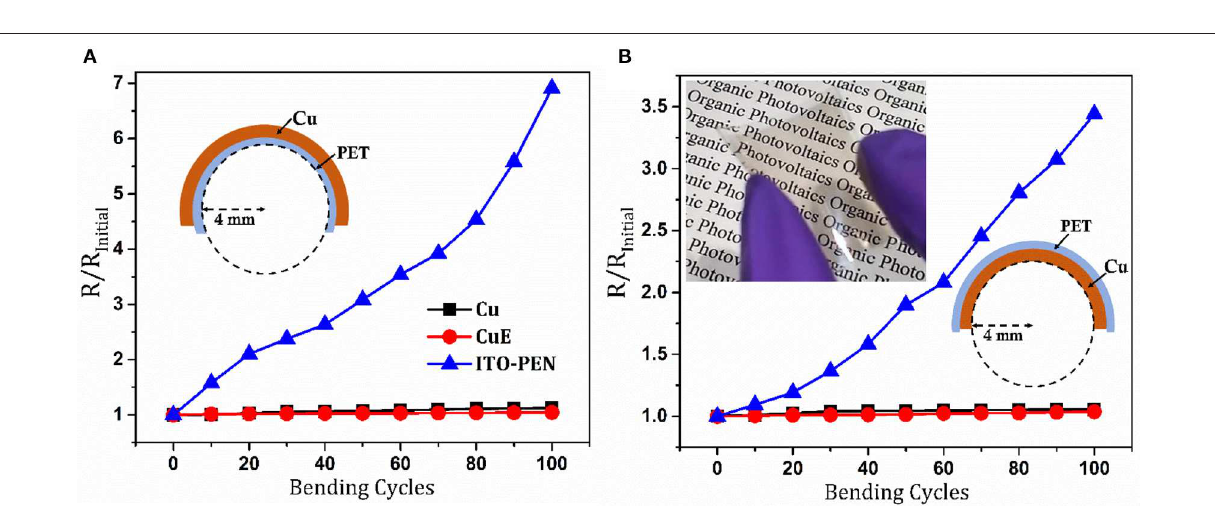
FIGURE 4 | Change in R sh when the Cu, CuE electrodes supported on PET and ITO coated PEN electrodes are subjected to repeated bending in the (A) outward (stretched) and (B) inward (compressed) directions. Inset: A photograph of a flexible CuE electrode with a ZnO ( ∼ 62nm)